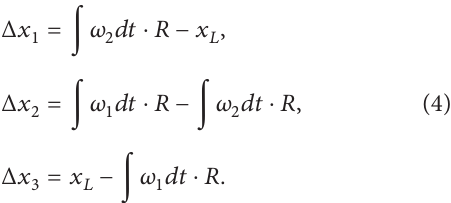
𝑐 1 and 1 are the elasticity and viciousness of 𝐿 3 .